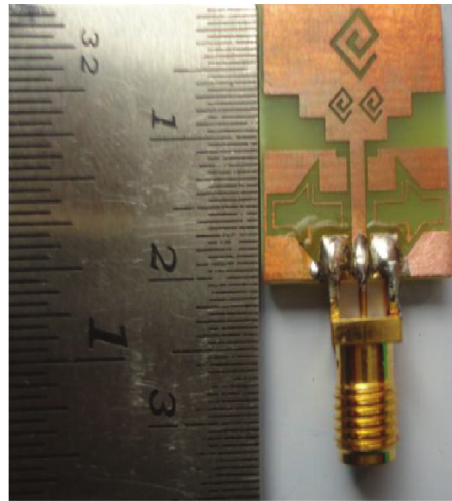
Figure 2: Photograph of the proposed antenna.